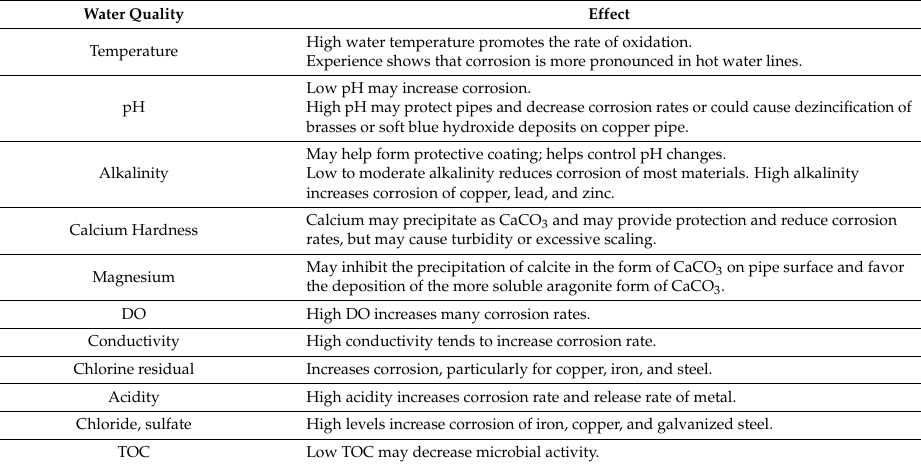
Table 6. Effects of water quality on pipe corrosion.